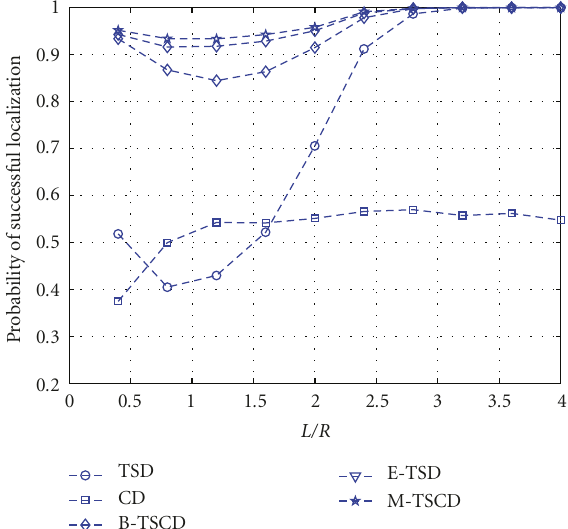
Figure 4: Performance of existing schemes and our schemes (the step length is 0 . 25 R for the mobility-aided TSCD